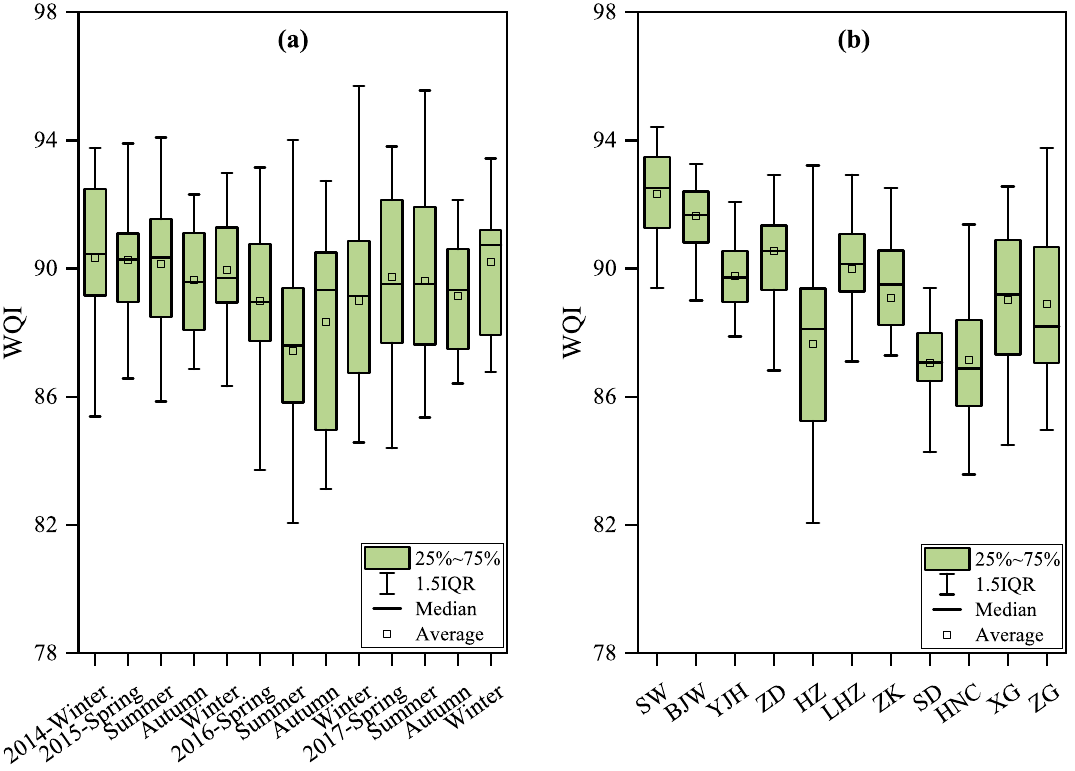
Figure 3. Seasonal ( a ) and spatial ( b ) variations of the water quality index (WQI) in the middle and lower reaches of the Han River basin in China from 2015 to 2017. WQI min - w (weighted) WQI min - nw (non-weighted) Parameter selection Models R